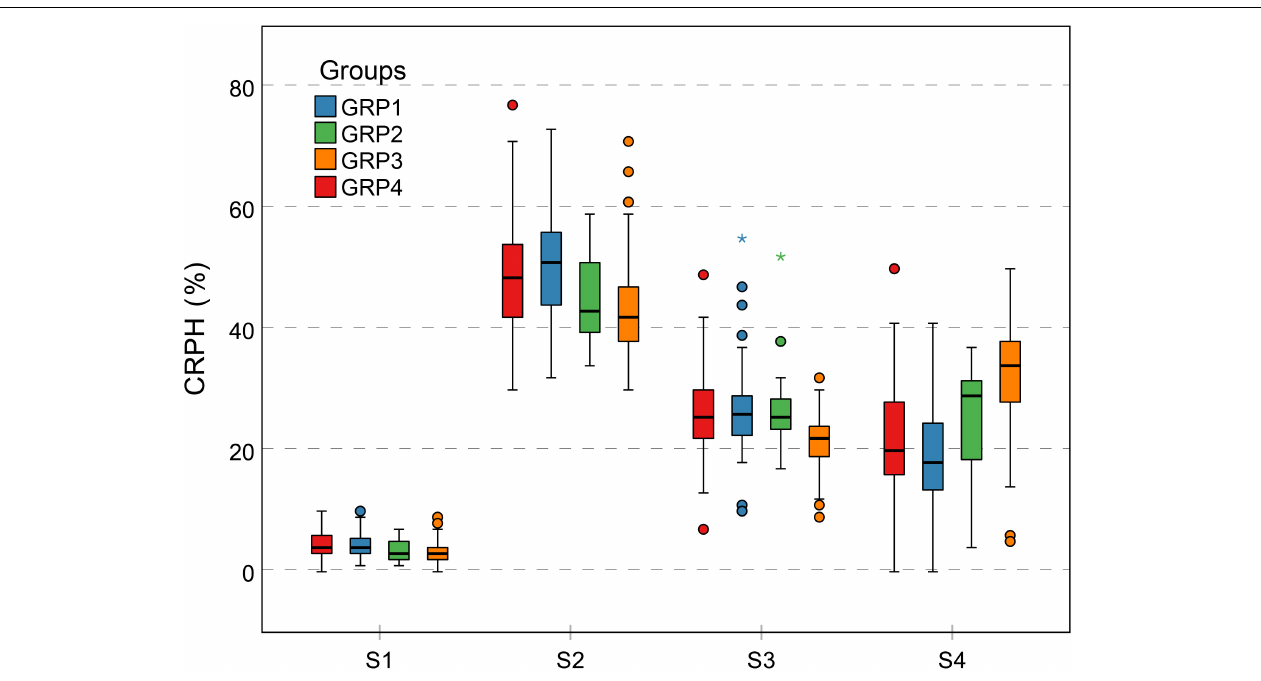
FIGURE 12 | Grouped boxplot for genetic background of CRPH trait. Outliers are shown as dots and asterisks. The vertical Y -axis represents the CRPH grouped according to genetic background, and the horizontal X -axis represents four growth stages. The difference in CRPH between the four groups is relatively large at the S2 and S4 growth stages. CRPH, contribution rate of plant height.